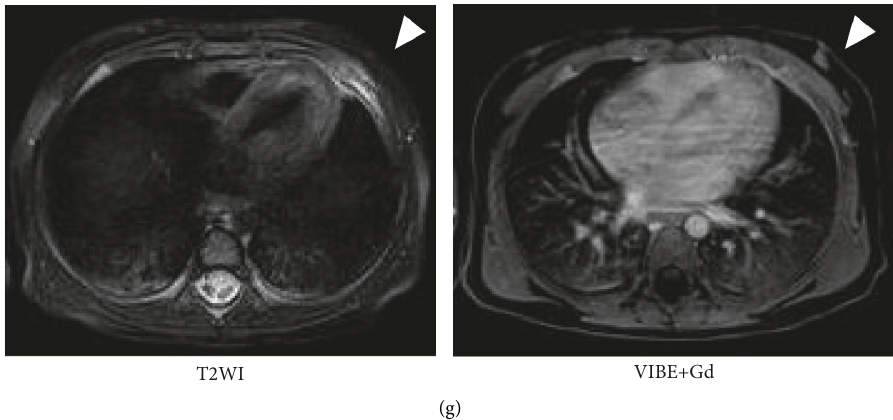
Figure 1: (a) Chest X-ray at admission. The permeability in the left middle and lower lung fields is decreased. The left diaphragm is elevated and the left costophrenic angle is dull. (b) Physical findings of the left anterior chest at the time of diagnosis. The left anterior chest is swollen without redness, and the nipple on the affected side is displaced to the upper left. (c) Initial enhanced chest computed tomography (CT) scan on the second day of admission. A low absorption lesion with a contrast effect is detected around the fifth rib, which suggested a chest wall abscess. Left pleural effusion with low volume is detected. (d) T2-weighted and T1-weighted + gadolinium (Gd) chest magnetic resonance imaging (MRI) on the 3rd day of admission. A high signal on T2-weighted images was observed from the anterior part of the left fifth rib to the transitional part of the costal cartilage. (e) T2-weighted and gadolinium-enhanced chest MRI on the 15th day of admission. The size of the abscess around the left fifth rib is greatly reduced. A contrast-enhanced area can be seen from the anterior part of the left fifth rib to the transitional part of the costal cartilage, resulting in the diagnosis of left fifth rib osteomyelitis. (f) Physical findings of the left anterior chest at the time of after 38 days of treatment. Swelling around the left fifth rib and papillary deviation are improving. (g) T2-weighted and gadolinium-enhanced chest MRI on after 38 days of treatment. The contrast area of the anterior portion of the fifth rib to the costochondral transition of the ribs is also